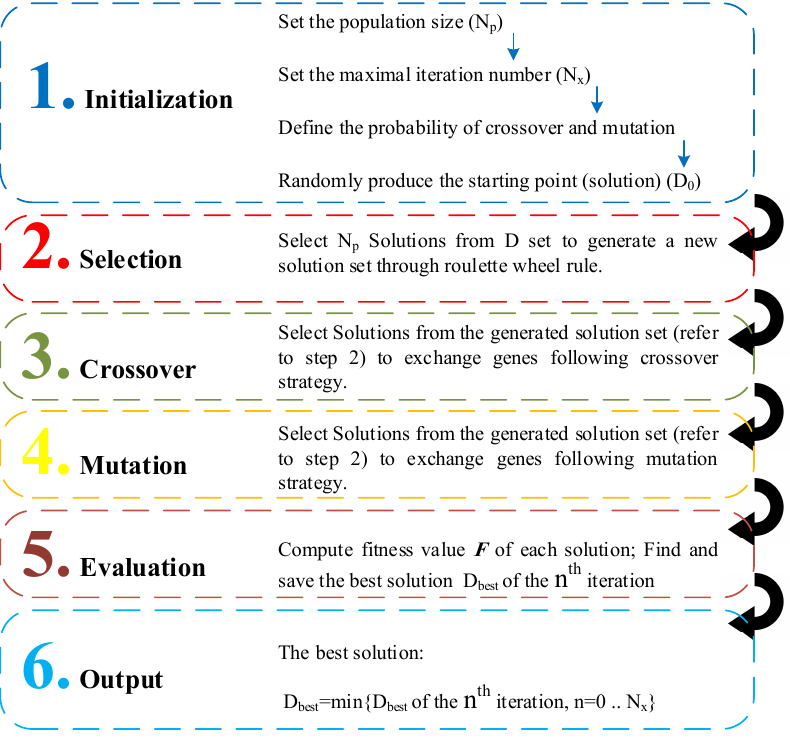
Figure 4. The genetic algorithm (GA) procedure.